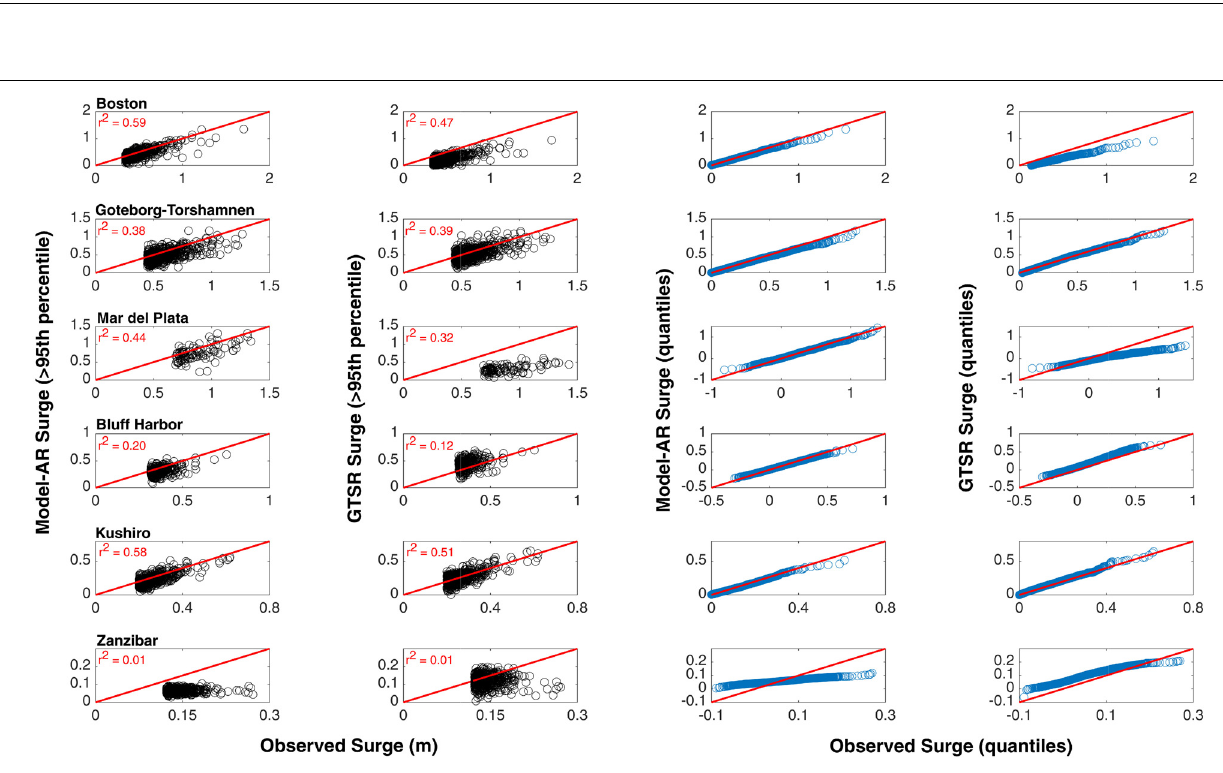
Frontiers in Marine Science |